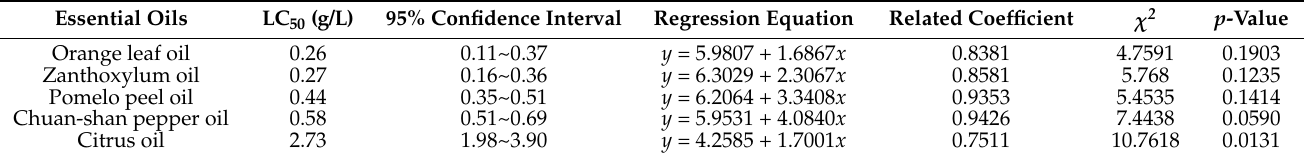
Table 2. The gastric toxicity of five Rutaceae essential oils to adult Thrips flavus .